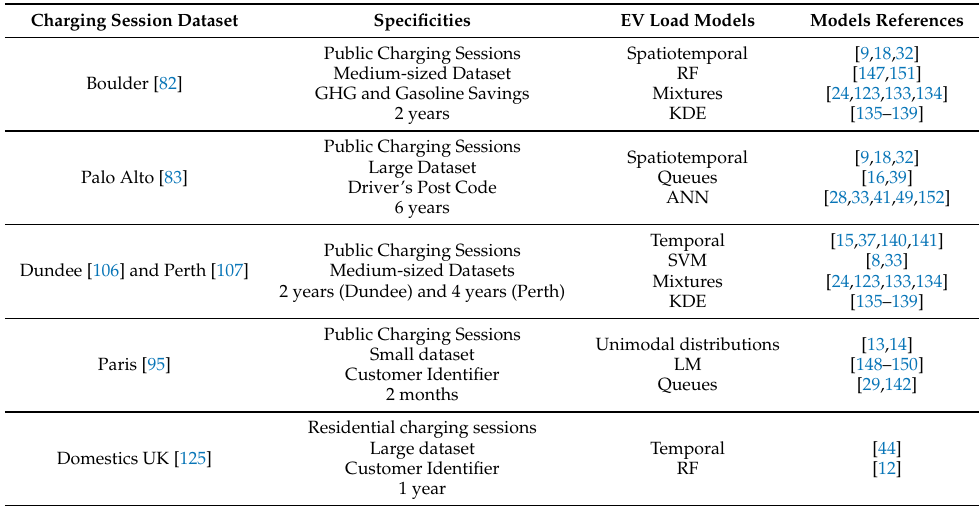
Table 6. Charging session datasets with associated EV load models suggested.